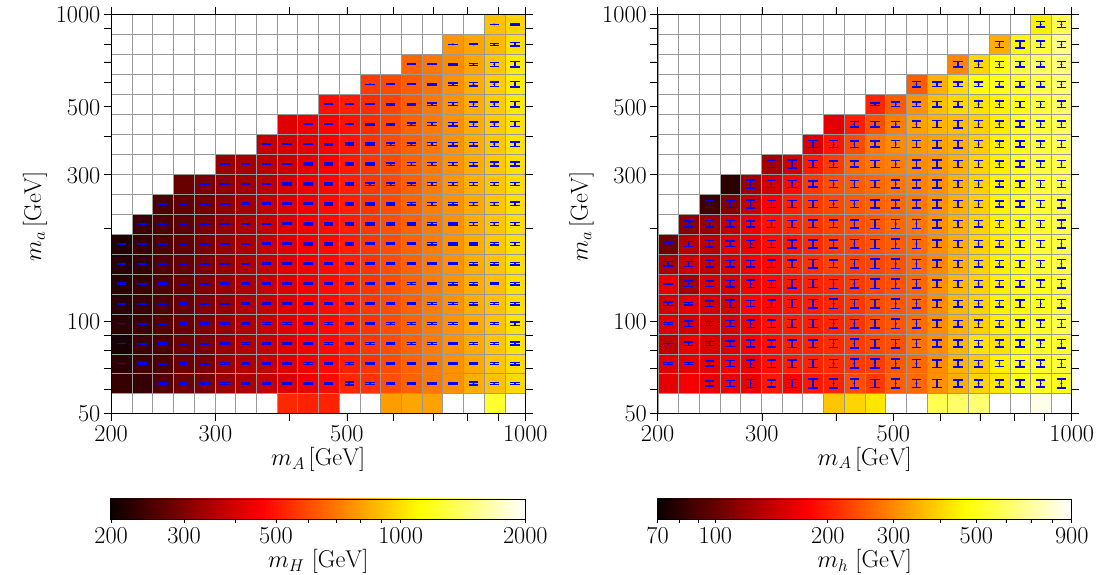
Figure 1 . The additional CP-even non SM-like Higgs boson masses m H and m h in the NMSSM parameter space. We show the statistical properties of points from our parameter scan as discussed in the text. The color scale in the left (right) shows the mean of the mass of H ( h ) in the m A { m a plane. Recall that the non SM-like states are de(cid:12)ned by their mass ordering, m h < m H and m a < m A . For the observed SM-like 125 GeV Higgs state we reserve the notation h 125 . As discussed in the text, usually the heavier states H and A are mostly composed of the non SM-like doublet interaction states, while the lighter states h and a are usually singlet-like. The blue error-bars show the standard deviation of the masses in the respective bin, normalized such that the error-bar would span the height of the bin if the standard deviation is equal to the mean. Note that the scale of the error-bar is linear with respect to the bin height, while the bin widths as well as the color scale are logarithmic. Note also the di(cid:11)erent color scaling for the masses in the left and right panels. Bins containing only 1 data point receive no error-bar, while bins without any data points are